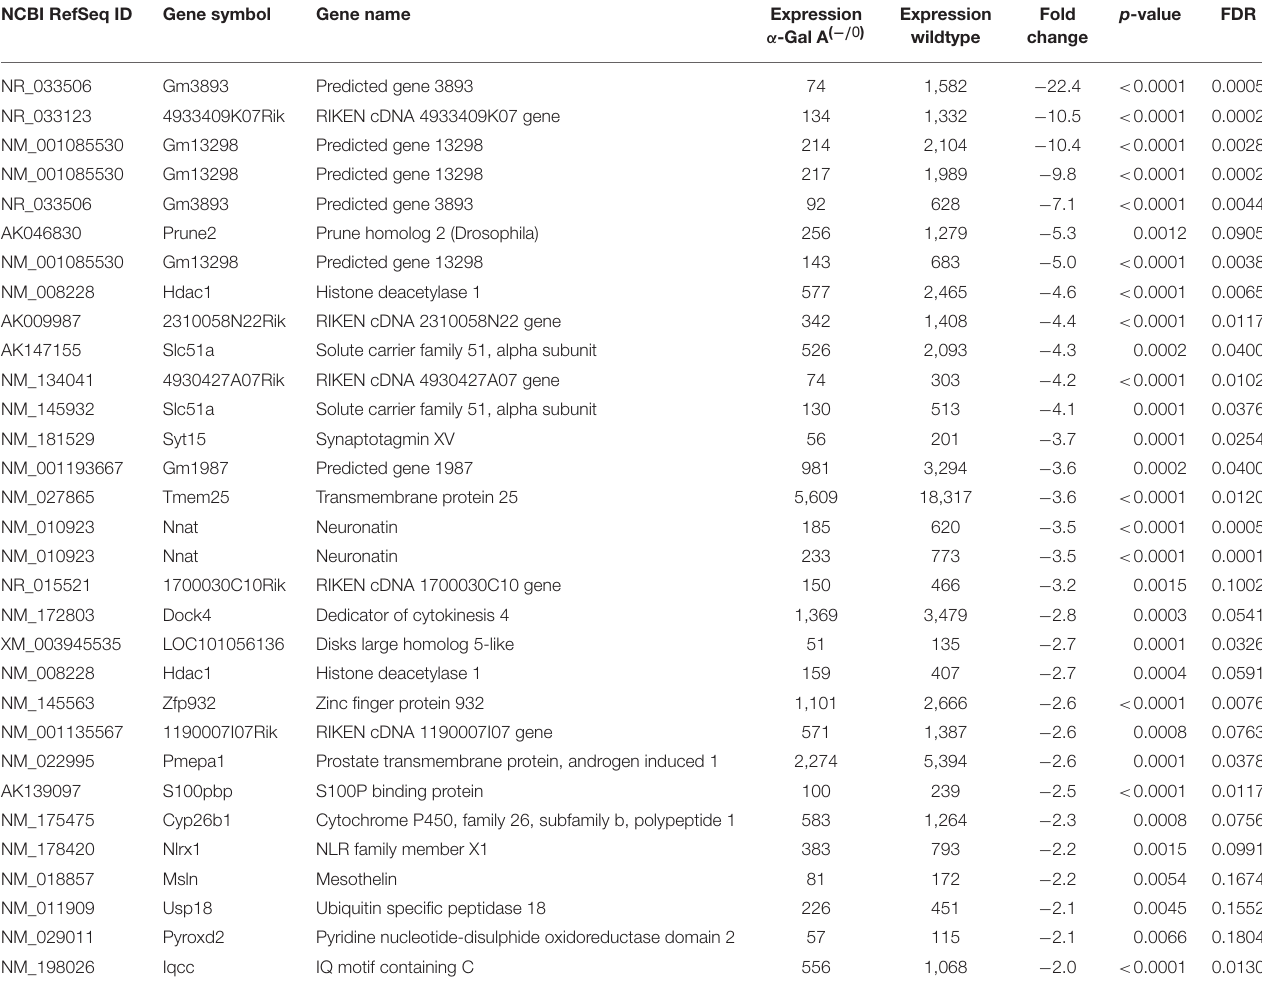
TABLE 2 | Raw expression values, fold changes, and statistical analysis for significantly downregulated